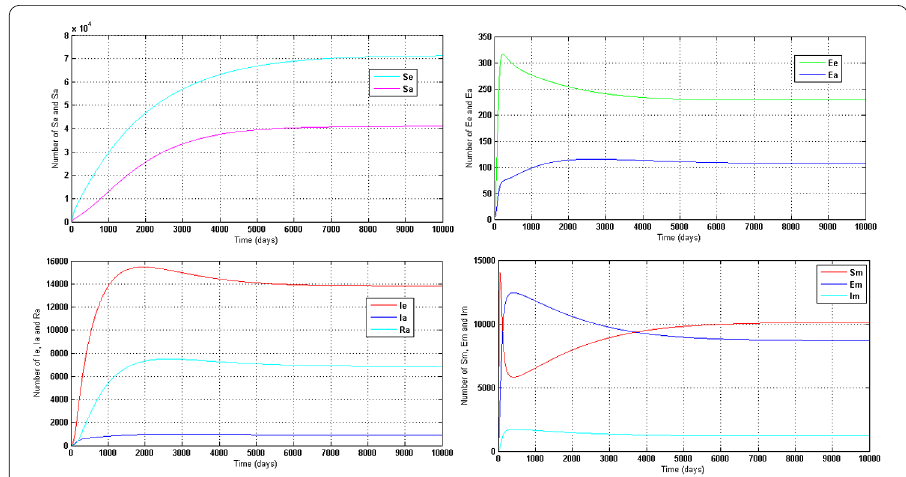
Figure 6 Evolution of the different clinics classes of the human population for p = 0.8, (cid:9) h = 50, c me = 0.03, c ma = 0.022, c em = 0.45, c am = 0.35, ˜ c me = 0.002, ν e = 0.10, ν a = 0.09, ν m = 0.083, α a = 0.01, α e = 0.001, γ e = 0.000018, γ a = 0.00003, β a = 0.0027, f h = 0.00063, f m = 0.1, n a = 0.5, b = 10.7, S E = 0.4, d E = 0.36, s L = 0.5, d L = 0.34, s P = 0.3, d P = 0.17 and f m = 0.15. These values lead to r = 14.26 and R 0 =